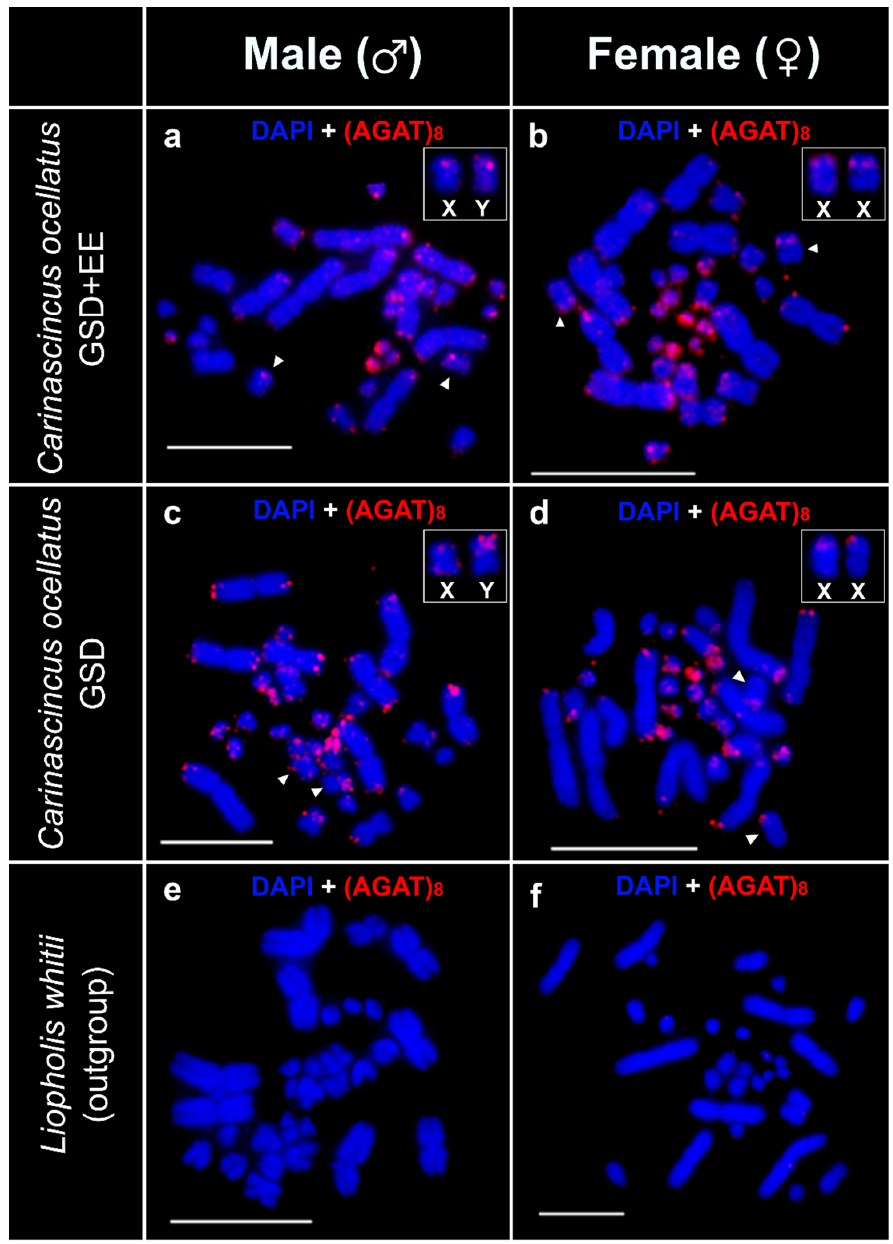
Figure 7. Chromosomal locations of the (AGAT) 8 repeat (red) on Carinascincus ocellatus GSD+EE (low elevation) male ( a ) and female ( b ), GSD (high elevation) C. ocellatus male ( c ) and female ( d ) and Liopholis whitii male ( e ) and female ( f ). C. ocellatus sex chromosomes inset. White arrowhead indicates X and Y (the homologous pair) chromosomes in C. ocellatus . Scale bars represent 10 µm.